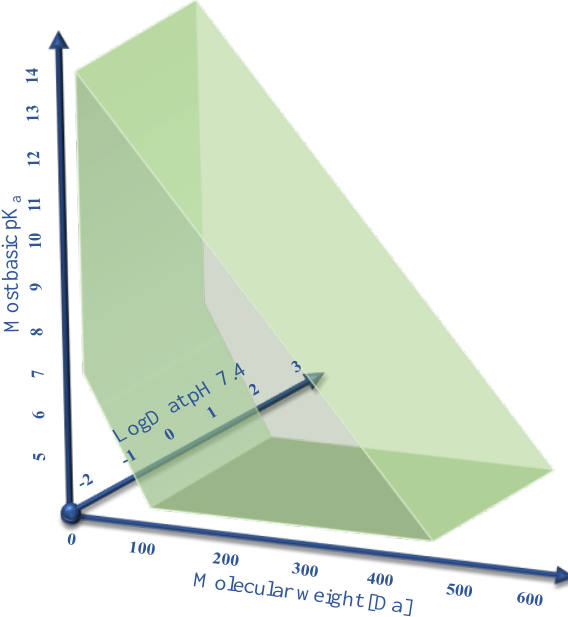
Figure 1. Illustration of the three primary parameters defining OCT1 substrates: a pK a value above 7, a molecular weight below 500 Da, and a logD at pH 7.4 below 1.5. Here, we studied if there are also OCT1 substrates beyond these limits with a particular focus on the charge of the substrates. In this respect, neutral substances, and particularly negatively charged substances, are atypical substrates, but also zwitterionic substances are not typical substrates of OCT1. Within OCT1, the negatively charged amino acid aspartate at position 474 (Asp474), located in transmembrane helix 11, has been identified to contribute to substrate binding.